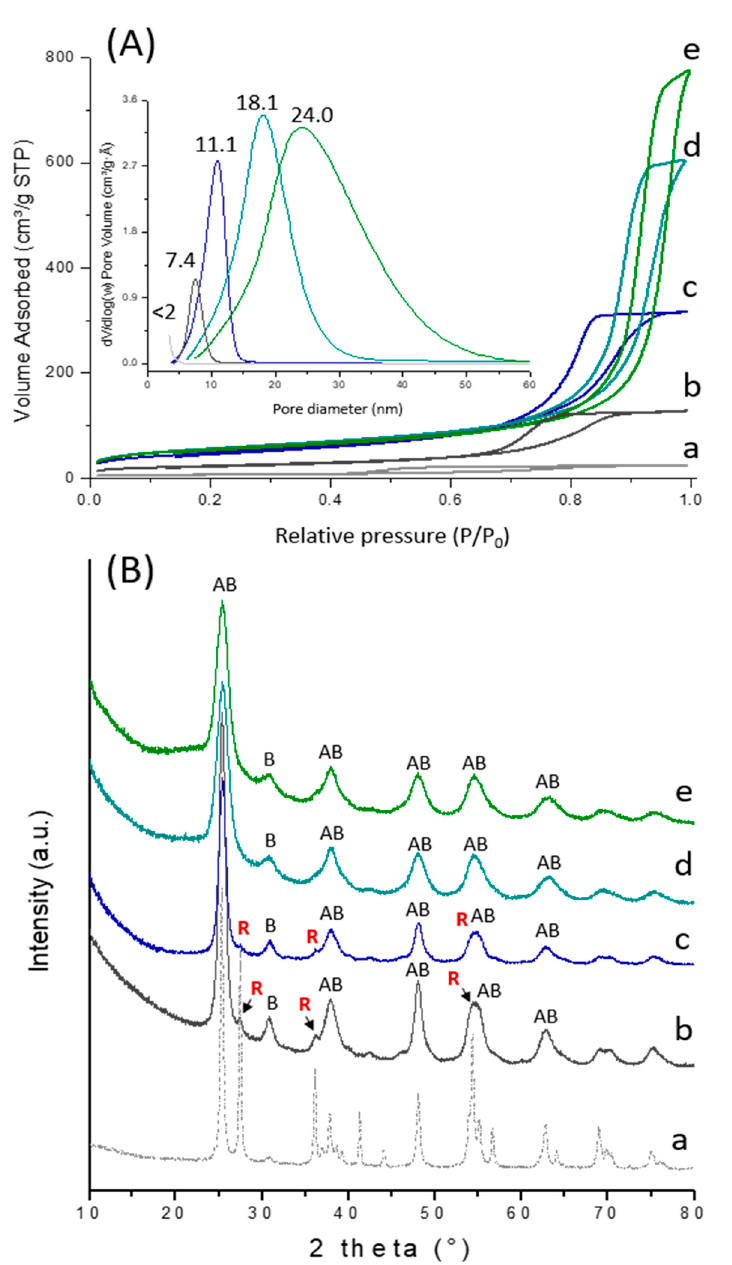
Figure 3. N 2 -adsorption isotherms and corresponding pore size distributions (inset) ( A ) and XRD patterns ( B ) of TiO 2 -sg (a), TiO 2 -ns (b), TiO 2 -SiO 2 3:1-ns (c), TiO 2 -SiO 2 3:2-ns (d), TiO 2 -SiO 2 3:3-ns (e). The “A”, “B” and “R” denote the anatase, brookite and rutile phases respectively.